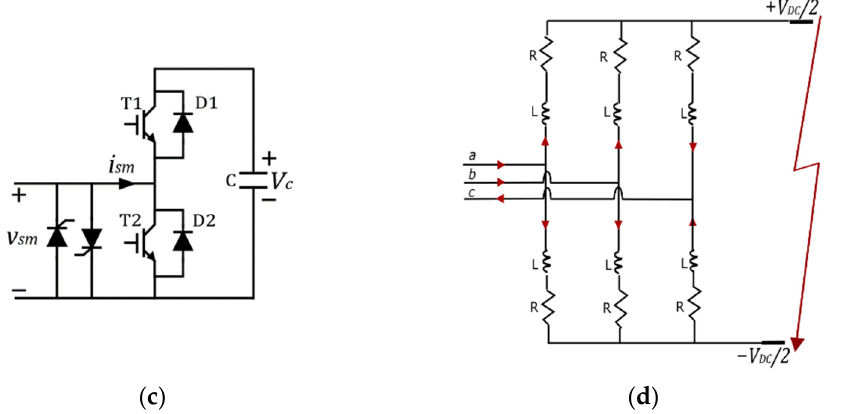
Figure 6. ( a ) Single thyristor switch scheme; ( b ) Single thyristor switch scheme equivalent circuit during fault; ( c ) Double thyristor switch scheme; ( d ) Double thyristor switch scheme equivalent circuit during fault.